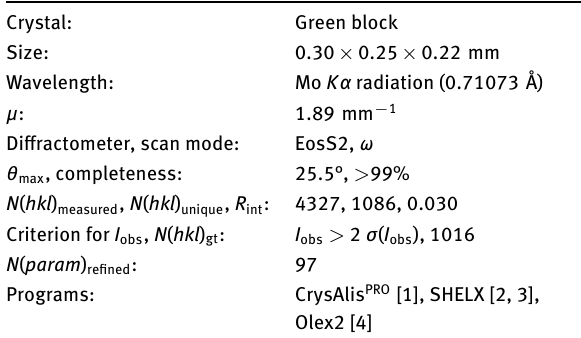
Table 2: Fractional atomic coordinates and isotropic or equivalent isotropic displacement parameters (Å 2 ).